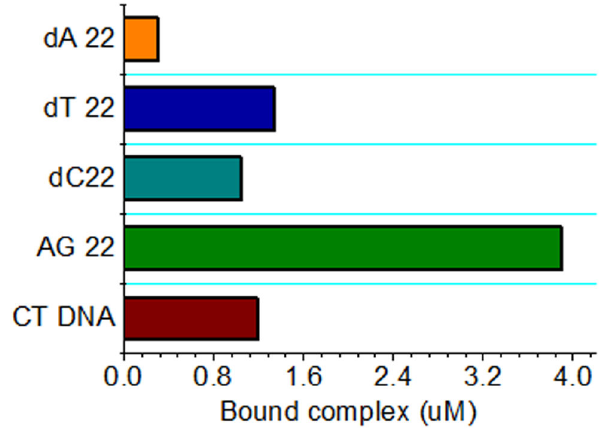
Figure 7. Selectivity for G-quadruplex DNA assessed by competition dialysis. Results of competition dialysis